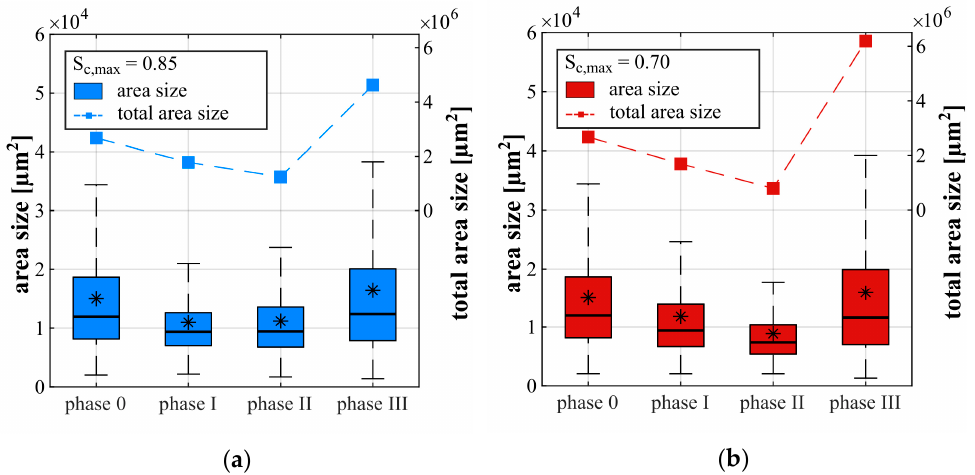
Figure 9. Sizes of bluish impregnated areas (boxplot, * represents the mean value) and total (cumu- lated) area size (dashed line) for stress level S c,max = 0.85 ( a ) and S c,max = 0.70 ( b ); ROIs of horizontally orientated thin sections H1 and H2.